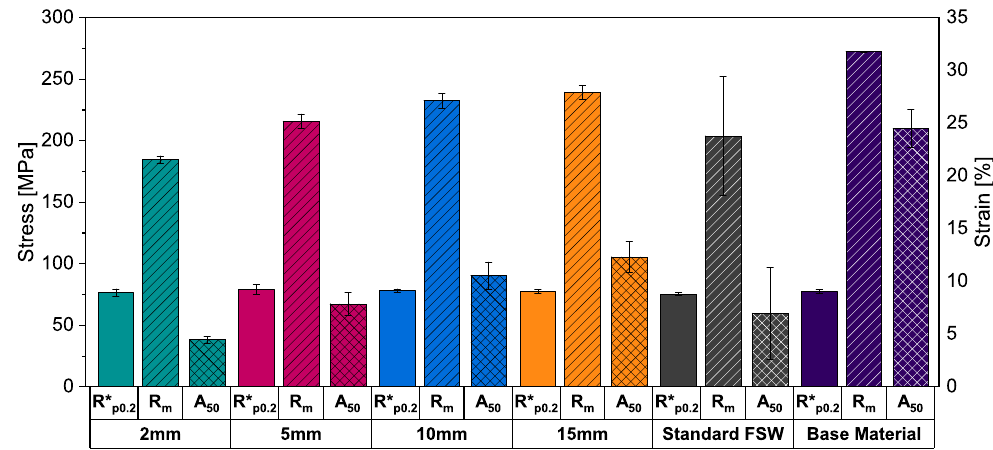
Figure 5. Tensile properties for all stitch weld lengths, the standard FSW and base material for